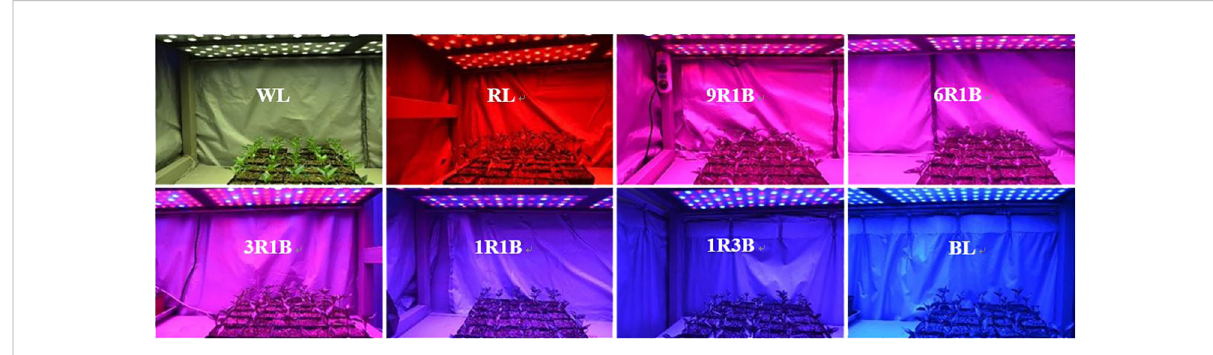
FIGURE 1 General view and spectral distribution of eight light spectra